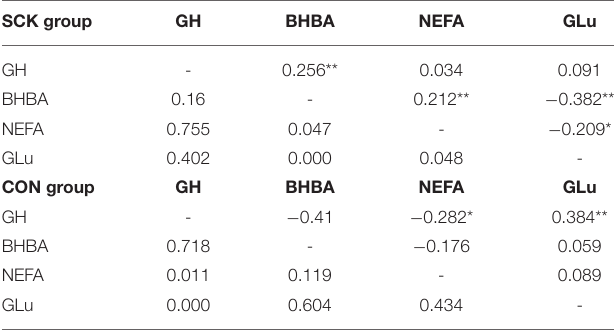
TABLE 3 | Determination of blood plasma levels of GH, BHBA, NEFA GLu indices in SCK and healthy control cows. Group